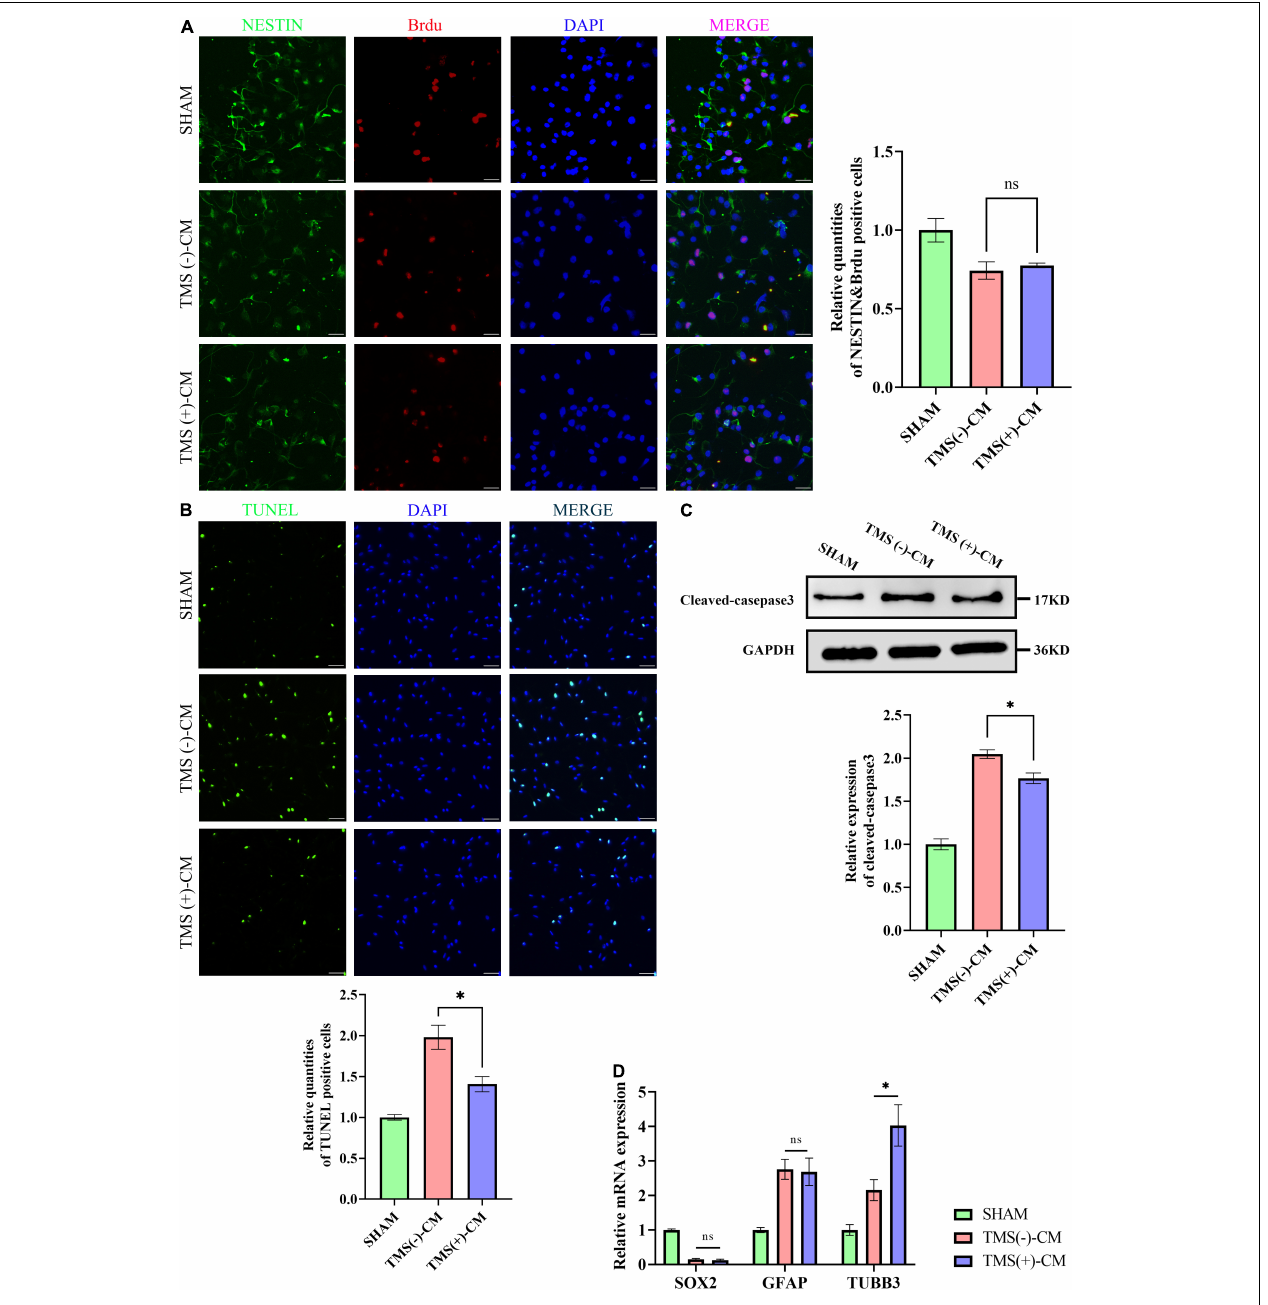
FIGURE 7 | Effect of microglia-derived conditioned medium (CM) on neural stem cells (NSCs). (A) Quantitative analysis of BrdU + and NESTIN + NSCs in NSCs treated with or without microglia-derived CMs ( n = 3), scale bar, 10 µ m. Quantity of NESTIN + and BrdU + cells in TMS (–) group was normalized as control. (B) Quantitative analysis of TUNEL-positive apoptotic cells in NSCs treated with or without microglia-derived CMs ( n = 3), Scale bar, 25 µ m. Quantity of TUNEL-positive cells in TMS (–) group was normalized as control. (C) Western blotting analysis of cleaved-caspase3 in NSCs treated with or without microglia-derived CMs ( n = 3). (D) Relative mRNA expression of SOX2, GFAP, and TUBB3 ( n = 3). Data are shown as mean ± SEM. Statistical significance was determined with the unpaired Student’s t -test. * P < 0.05, and ns means no significant.